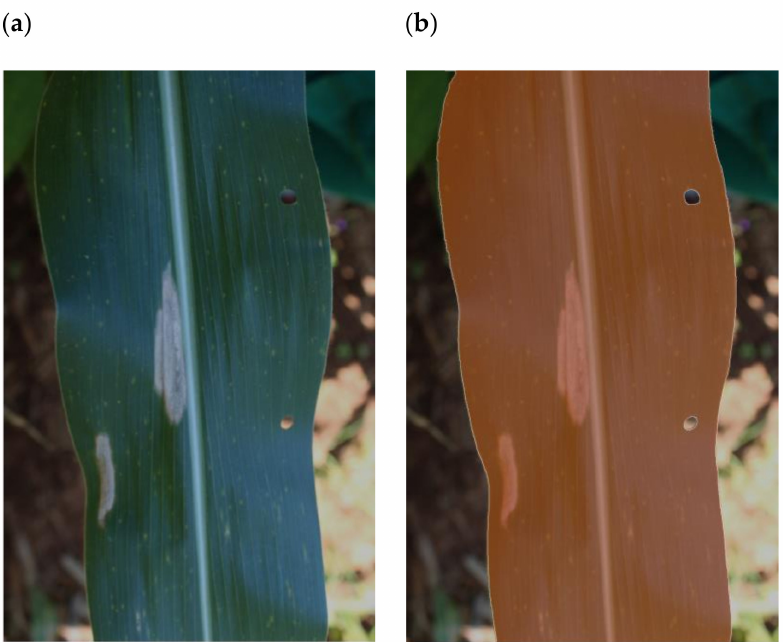
Figure 3. Example of image segmentation to define the leaf area for the “In-field_leaf” (IFL) dataset. ( a ) Original leaf image from the In-field (IF) dataset. ( b ) Leaf area from image ( a ) highlighted manually and shown by brown overlay using the tool available at https://segments.ai (accessed on 21 July 2022).